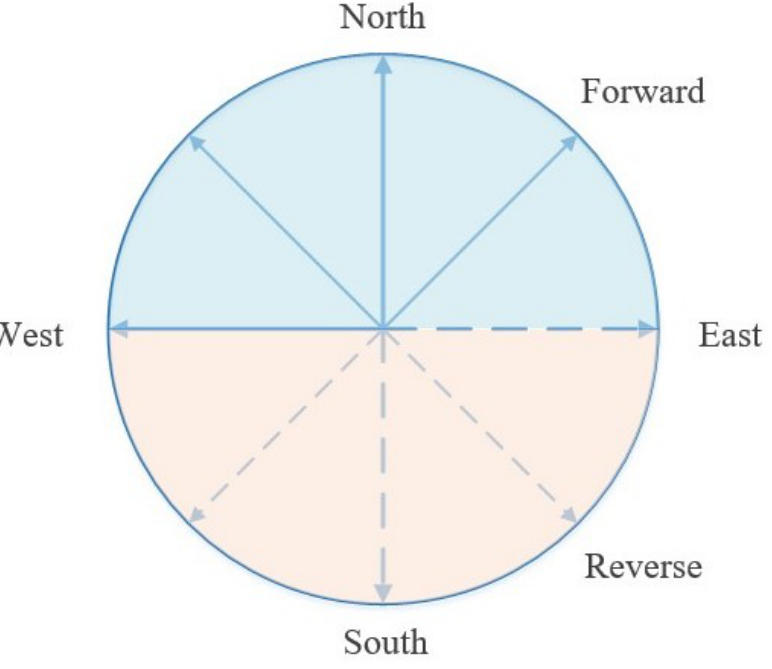
Figure 2. The directions of vehicle